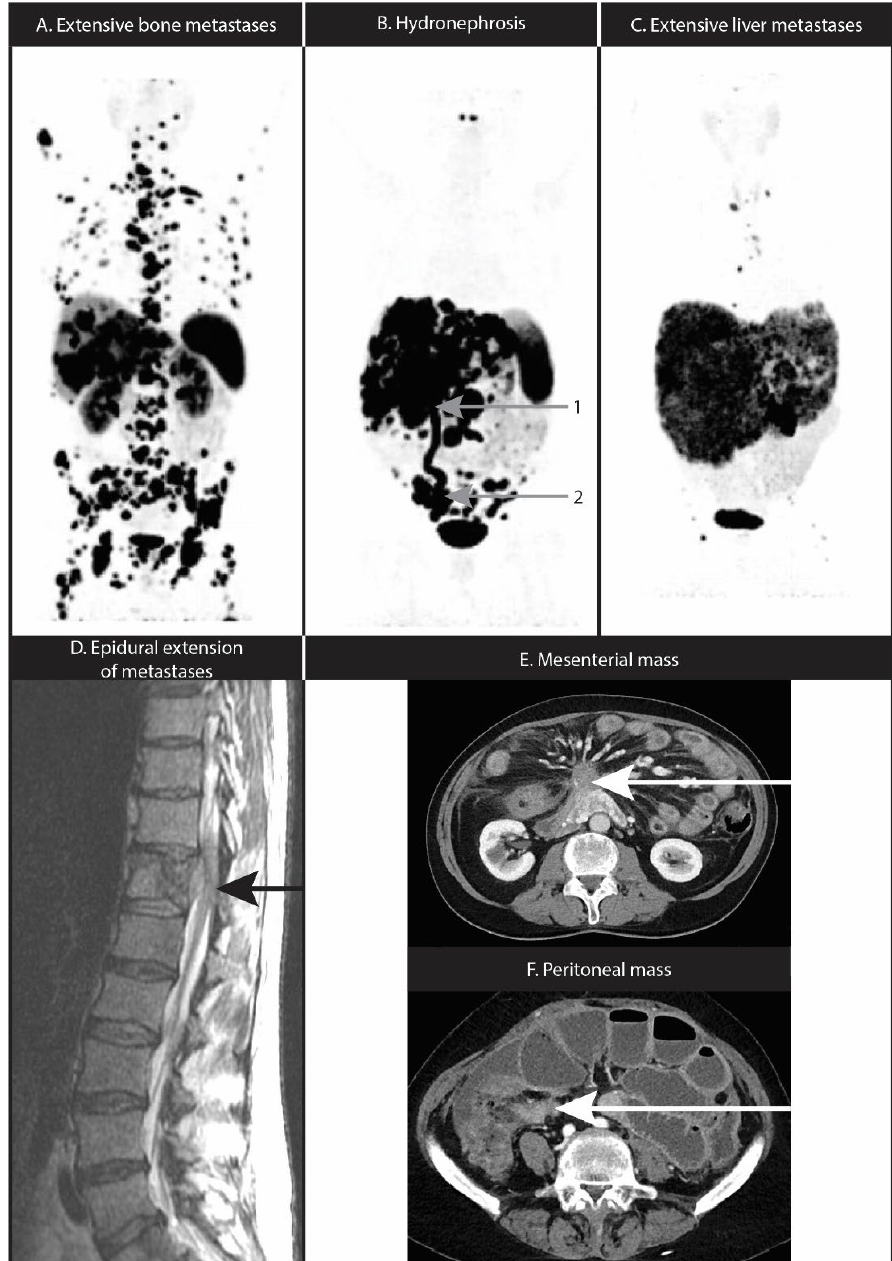
Figure 2. Potential complicated clinical situations for PRRT. ( A ) 68 Ga-DOTATATE PET scan of ex- tensive bone metastases of SI-NET. R-PRRT with reduced activity of 3.7 GBq 177 Lu-DOTATATE induced hematoxicity. ( B ) Hydronephrosis (1) due to obstruction by peritoneal tumor deposit of metastatic panNET (2), leading to accumulation of radioactivity in renal medulla. ( C ) 68 Ga-DOTATATE PET scan showing extensive liver metastases of panNET before treatment with 3.7 GBq 177 Lu-DOTATATE, which was well tolerated by the patient. ( D ) Bone metastasis of panNET with epidural extension at Th12 on MRI. Post-PRRT edema can lead to infringement of the spinal cord. ( E ) Patient with small bowel NET and metastatic mesenteric mass with desmoplastic reaction, result- ing in venous congestion, bowel wall thickening and ascites. The patient suffered from intermittent abdominal pain with temporary aggravation of complaints during PRRT. ( F ) Contrast enhanced CT scan of peritoneal metastases of a multifocal NET of a patient who developed a paralytic ileus or ‘frozen abdomen’ after